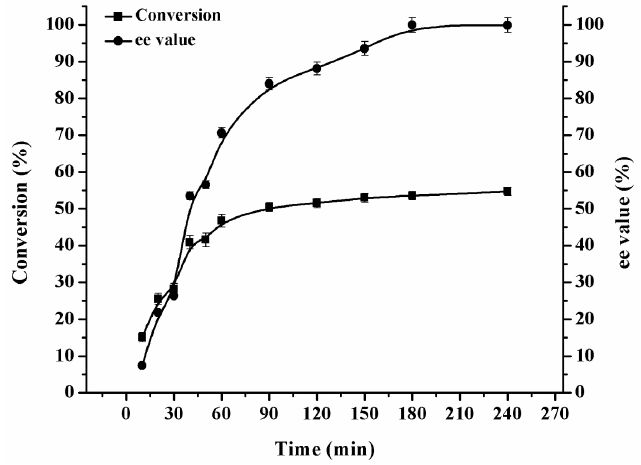
Figure 6. Time curve of resolution ( R , S ) ‐ 1 ‐ phenylethanol using 0.02 g immobilized BCL as catalyst in 45